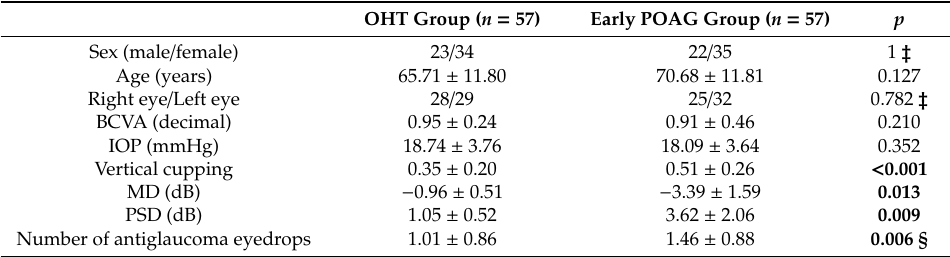
Table 1. Demographics and clinical data of the study groups.